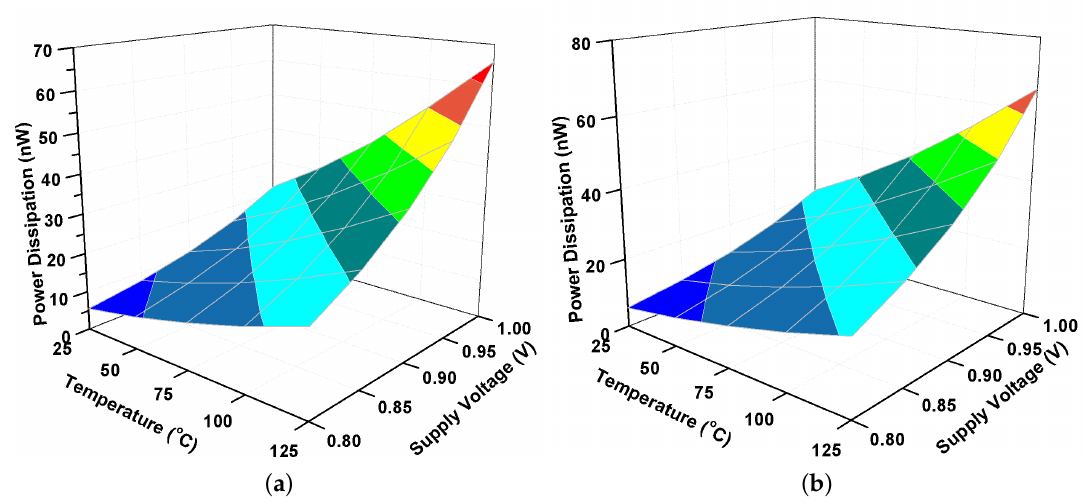
Figure 12. Power consumption for supply voltage and temperature variation for the ( a ) 6T SRAM cell and the ( b ) AS10T SRAM